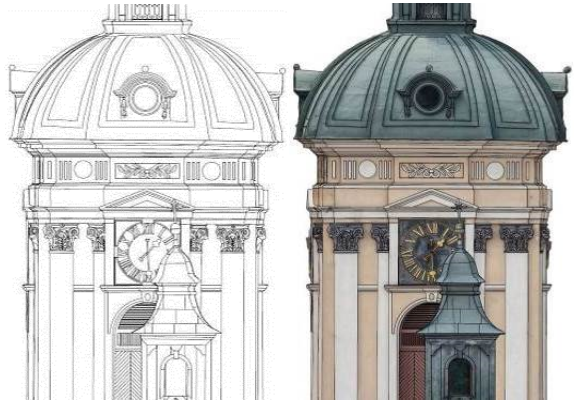
Figure 24. Part of the facade view of the church – drawing and drawing with orthoimage